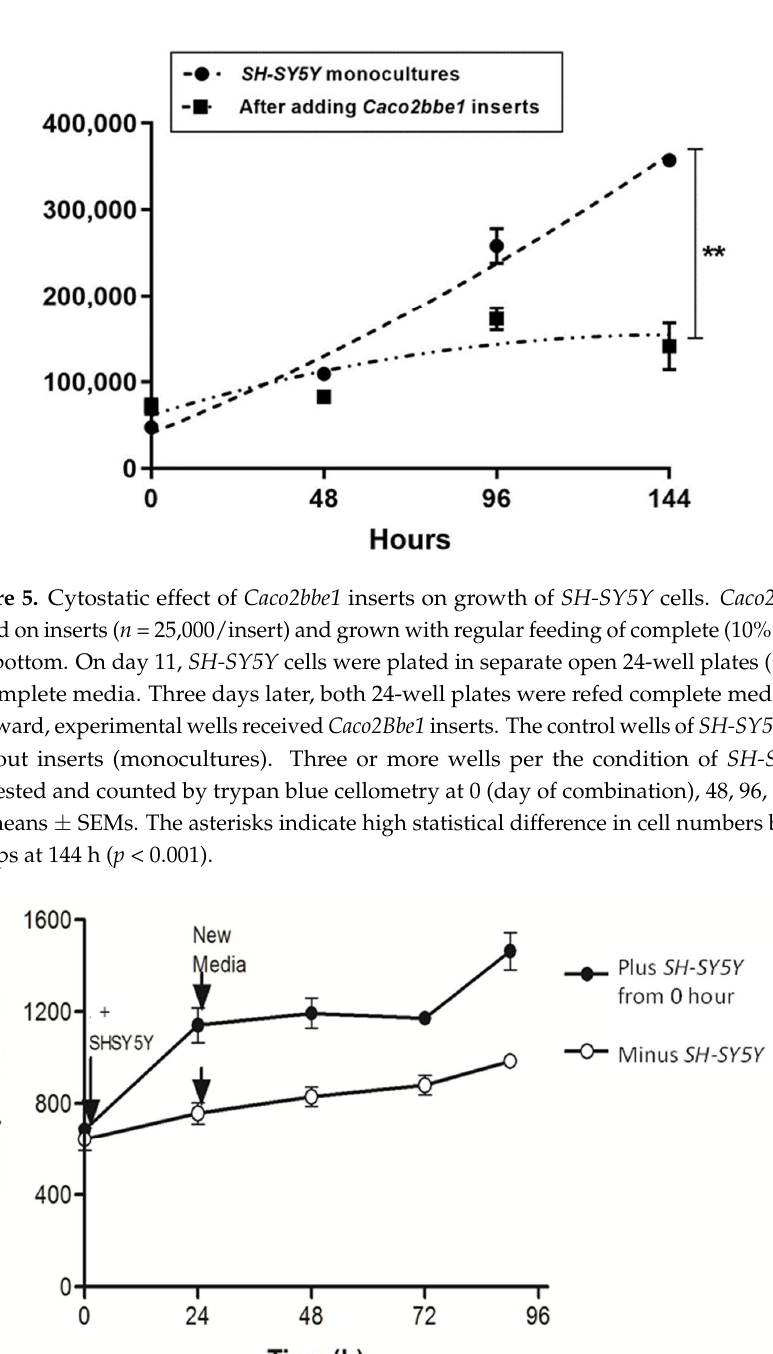
compact soma (Figures 7 and 8). But RA itself, was not the key to revealing neurite exten- sions independently of confounds. It was the removal of serum. When the SH-SY5Y cells were placed in serum-free media as requisite for RA to act, the absence of serum simulta- neously halted cell division. It was the ongoing ability of cells to divide that had previ- ously caused the cytostatic and cell spreading findings which were confounding our un- derstanding the neurites (Figure 6). Without serum in media, we realized that neither of these confounding phenomena occured in response to the Caco2bbe1′s . [Two asides: (1) the absence of cell division also became essential when we added the probiotics; and (2) we later experimented with a higher FBS level of 11% in apical media only to discover that the rise in serum led to an exaggeration of the previous finding of top-down promotion by epithelium for longer neurites in SH-SY5Y (similar Figure 7, compare bars 3 and 4)]. Put another way, once the serum was removed we became confident that any neurite en- hancements would not be confounded when treating (i.e., with probiotics) to secondary cytostasis and spreading-out responses due to the epithelium.